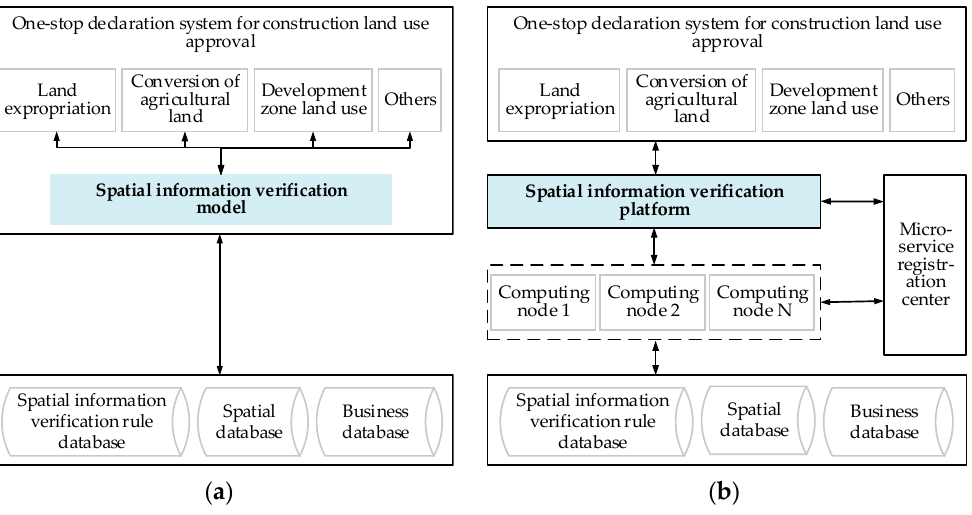
Figure 6. Comparison of architecture in the construction of spatial information verification function in One-stop declaration system for construction land approval: ( a ) Architecture of a monomer sys- tem; ( b ) Architecture of the system based on middle platform and